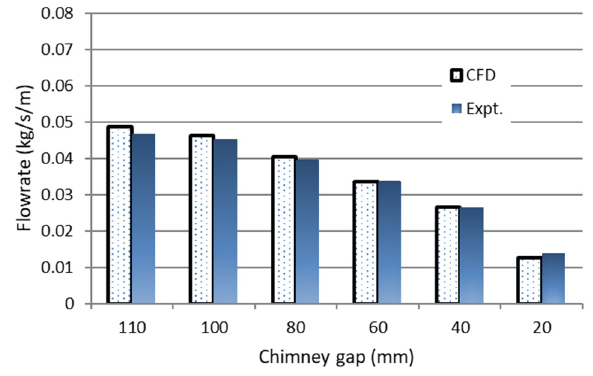
Figure 3. The CFD results were compared to the experimental ones by Burek and Habeb [7].